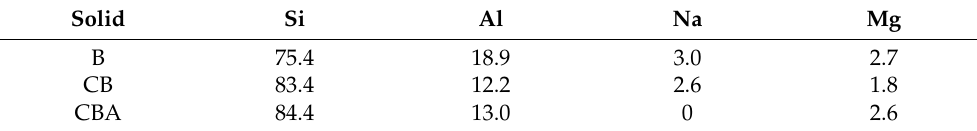
Table 1. EDS analysis of solids B, CB, and CBA. Compositions are expressed in Wt.%.